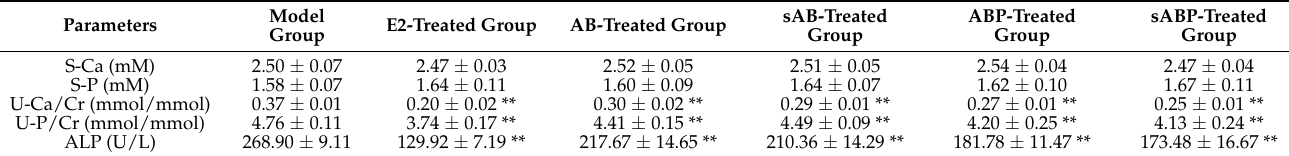
Table 1. Biochemical parameters of serum and urine of rats in different groups.